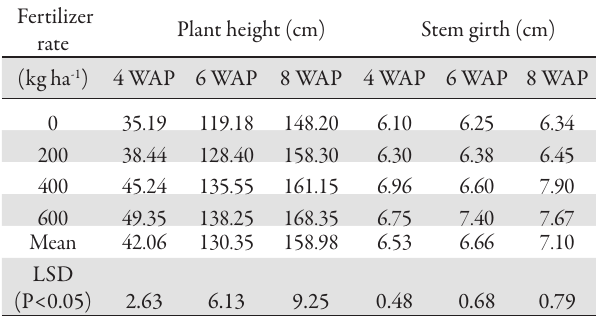
Tab. 1. Effects of NPK 15:15:15 fertilizer on the height and stem girth of maize ( Zea mays )